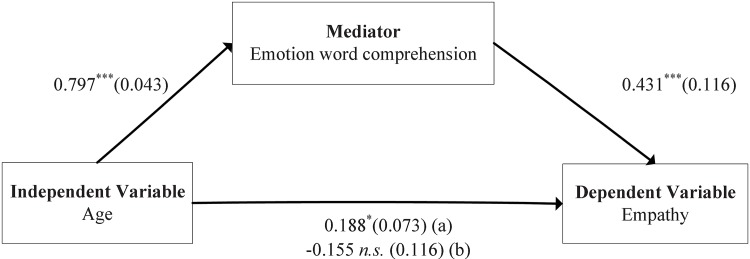
Mediation model describing the relationship among age, EWC and empathy.Path model showed Beta coefficients (Standard deviation, SD) after controlling gender in all regressions, with: (a) Beta coefficient (SD) without emotion word comprehension in the regression; and (b) Beta coefficient (SD) after controlling for emotion word comprehension in the regression. Note: *p<0.05; **p<0.01; ***p<0.001; n.s., no significance.